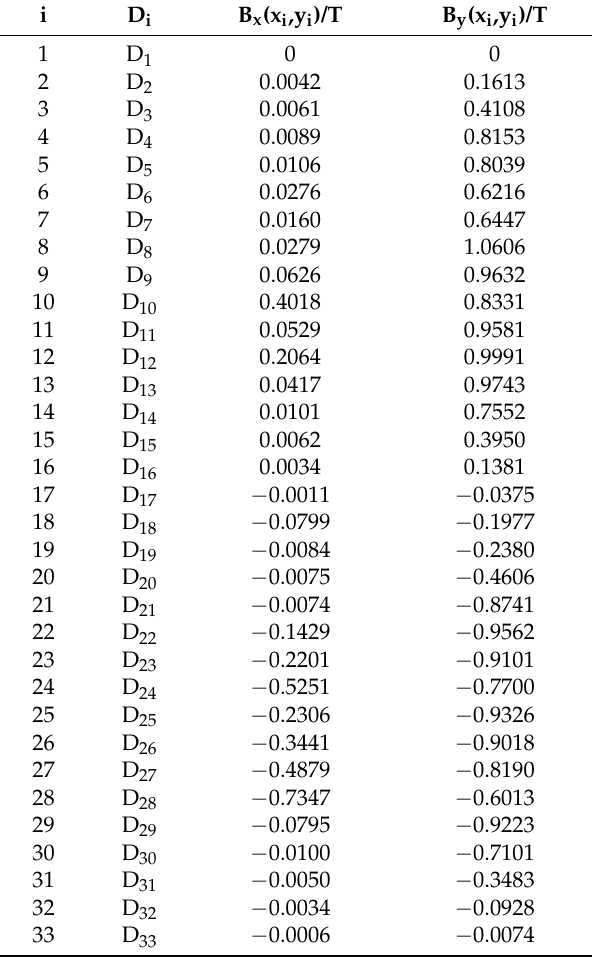
Table 2. Detection values of B x (x i ,y i ) and B y (x i ,y i ) with F = 0.2 and N =